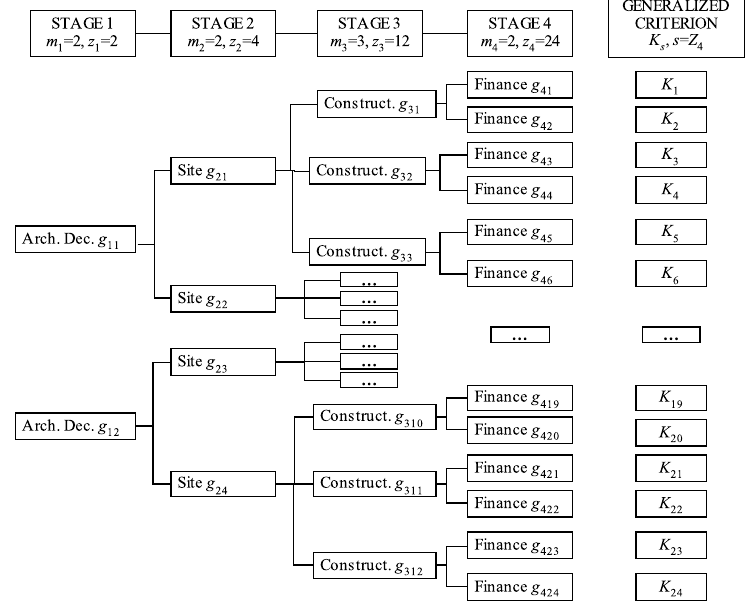
Fig. 1. A fragment of decision tree (DT) development by using multicriteria project synthesis methods (c =